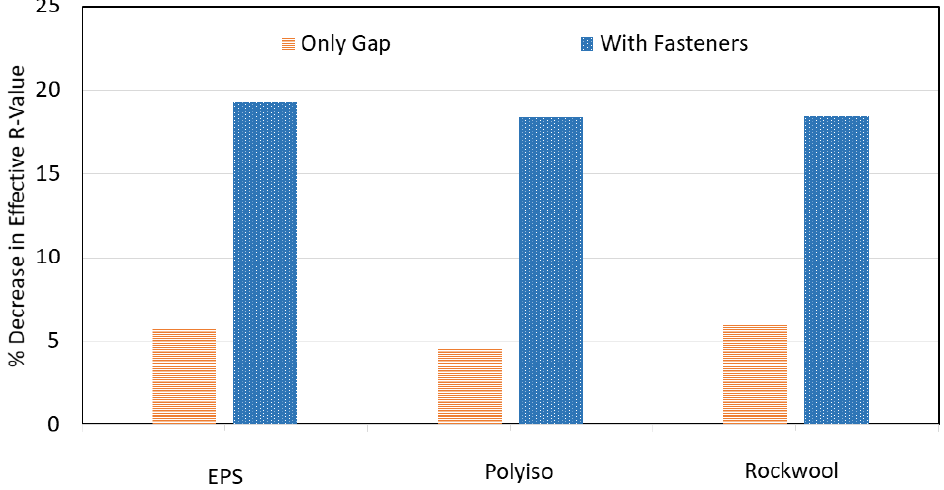
Figure 9. Decrease in Effective R-Value for R31 Systems tested with Fasteners and